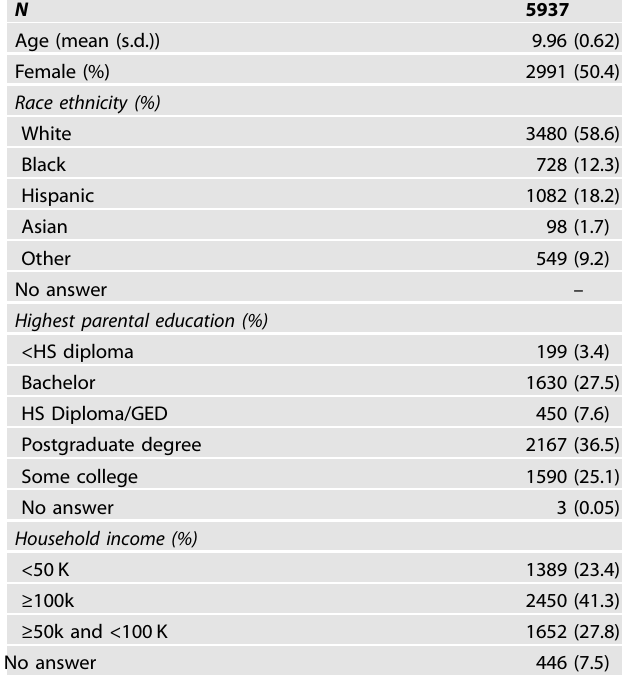
Table 1. Demographic characteristics of subjects included in neuroimaging